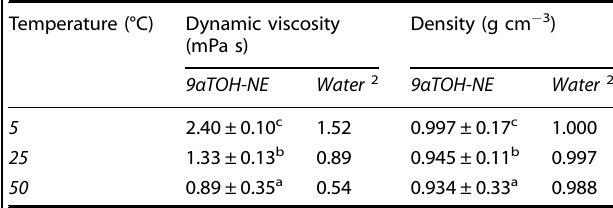
Table 3. Dynamic viscosity and density values 1 found for 9 α TOH-NE at 5, 25, and 50 °C compared to pure